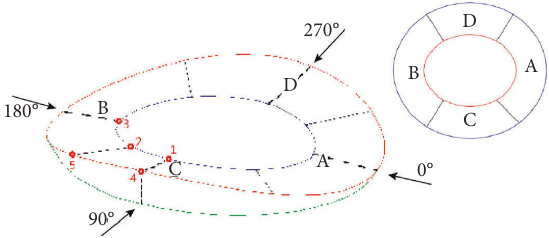
Figure 7: Definition of the wind direction